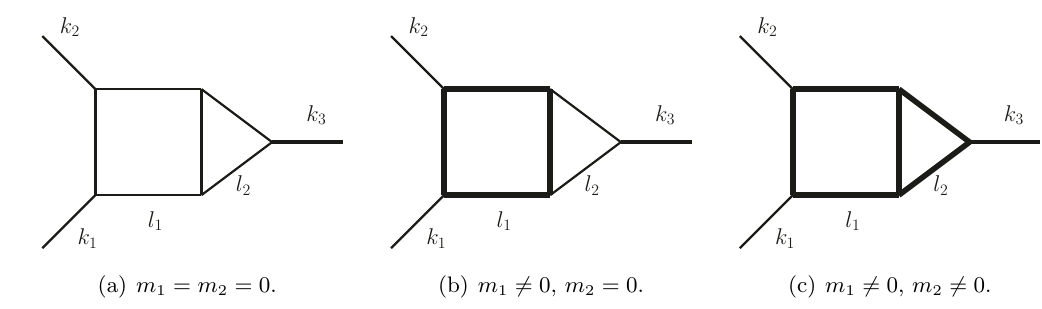
Figure 1 . Two-loop box triangle